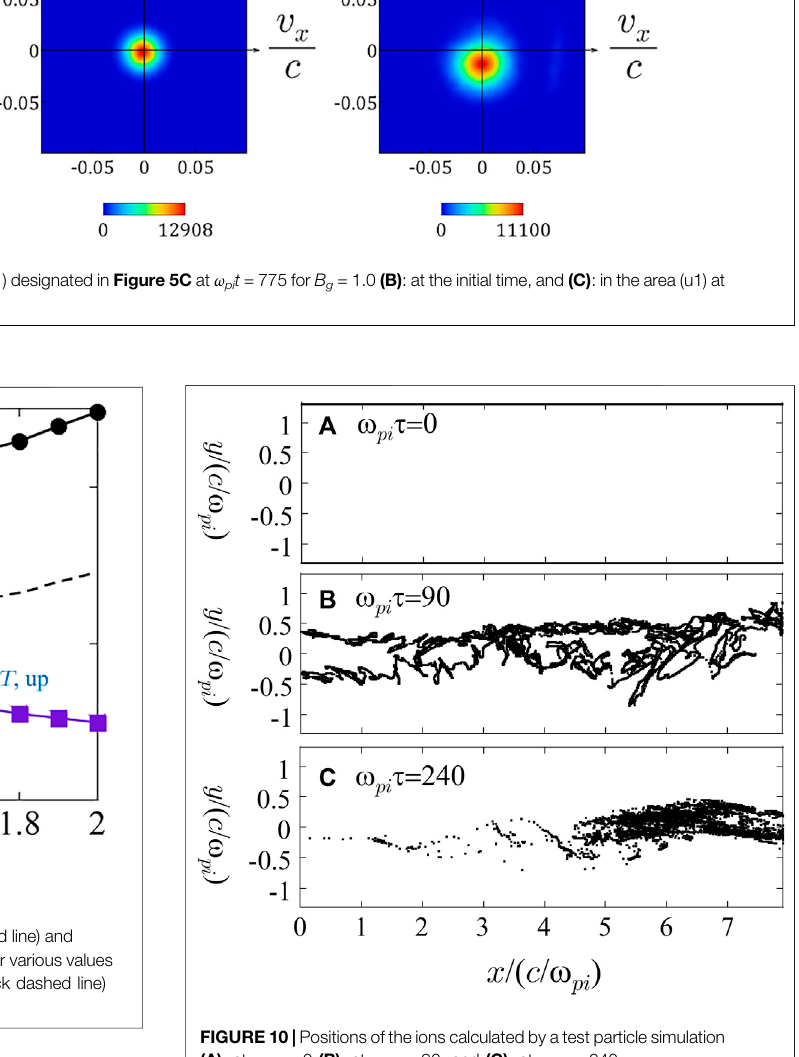
Frontiers in Astronomy and Space Sciences |